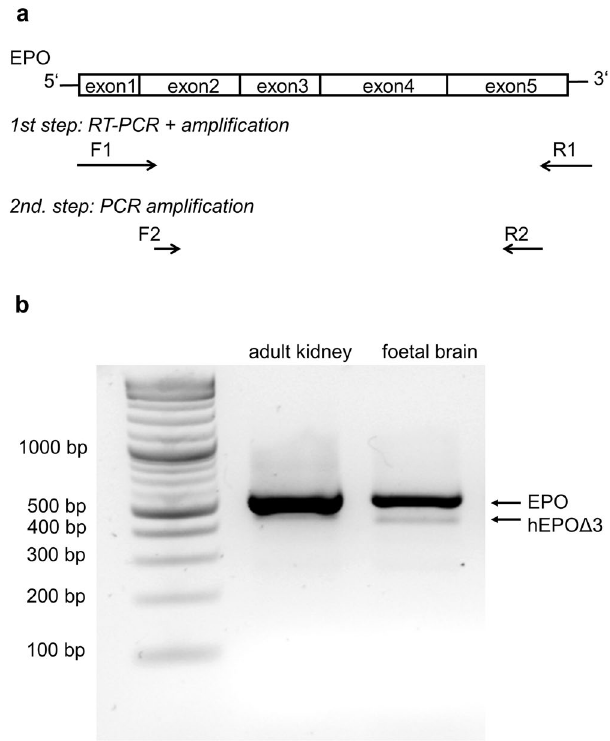
Figure 1. Isolation of the human EPO spliced transcript hEPO Δ 3. ( a ) Reverse transcription and PCR amplification is performed with a set of primers for full-length amplification of EPO lying 5 ′ and 3 ′ of the coding sequence in exon 1 and exon 5. Then some product is taken for re-amplification with an internally-situated set of primers lying in exon 2 and exon 5. ( b ) Agarose gel of EPO -PCR amplification products from human adult kidney and foetal brain reveals two products at 550 bp and 460 bp,